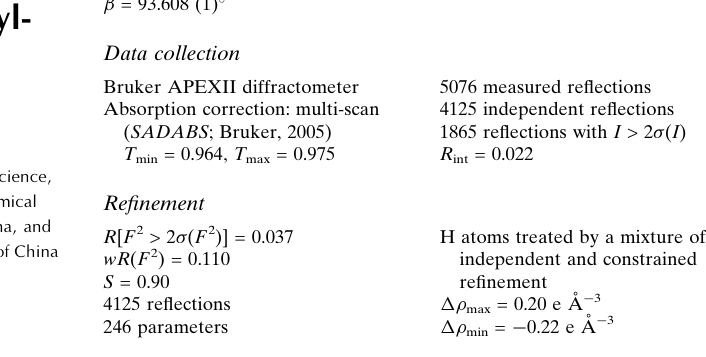
Bruker APEXII diffractometer Absorption correction: multi-scan ( SADABS ; Bruker, 2005) T min = 0.964, T max = 0.975